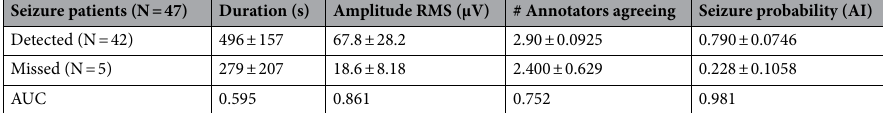
Seizure patients (N =